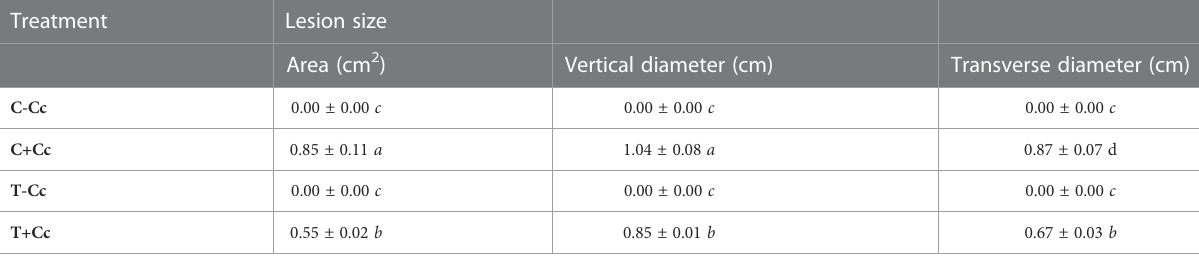
TABLE 2 Lesion size induced by AMF after inoculation with Colletotrichum camelliae.